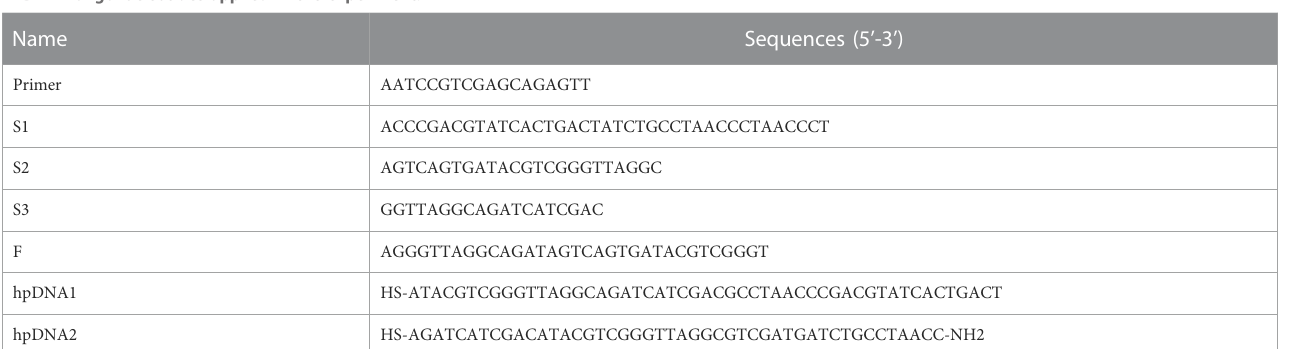
TABLE 1 Oligonucleotides applied in the experiment. Name Sequences (5 ’ -3 ’